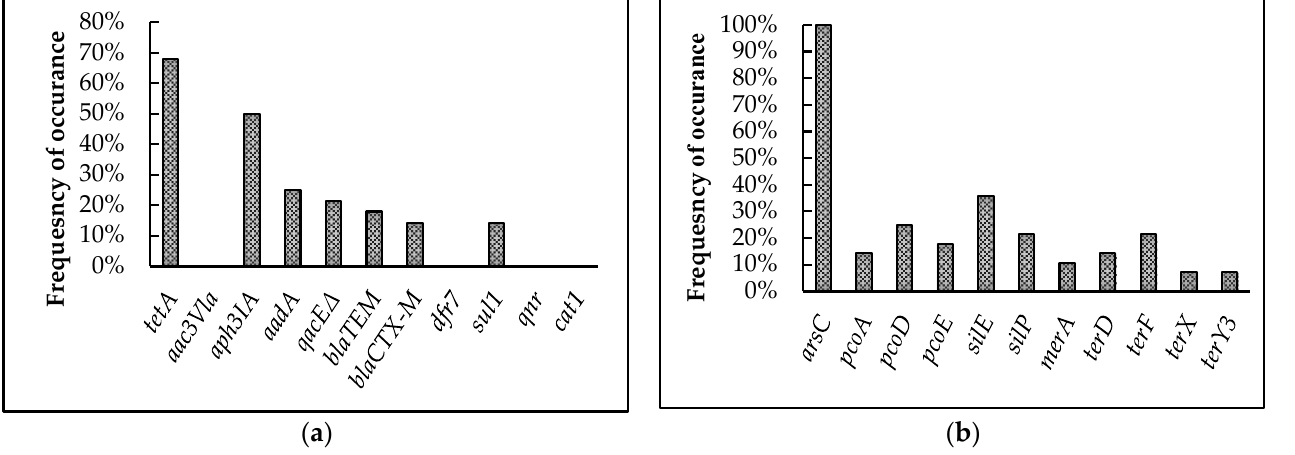
Figure 4. Prevalence of antimicrobial and heavy-metal resistance genes among broiler breeder APEC isolates. ( a ) Antimicrobial resistance genes tested in the 28 isolates. tetA confers resistance to tetracycline; aac3Vla , aph3IA , and aadA to aminoglycosides; qacE ∆ to quaternary ammonium compounds; blaTEM to β -lactamase; blaCTX-M to cephalosporins; dfr7 and sul1 to sulfonamides; qnr to quinolones; and cat1 to phenicols. ( b ) arsC confers resistance to arsenic; pcoA, pcoD, pcoE to copper; silE, silP to silver; merA to mercury; and terD , terF , terX , and terY3 to tellurium. Among the heavy-metal resistance genes, arsC (100%) was present in all the isolates.